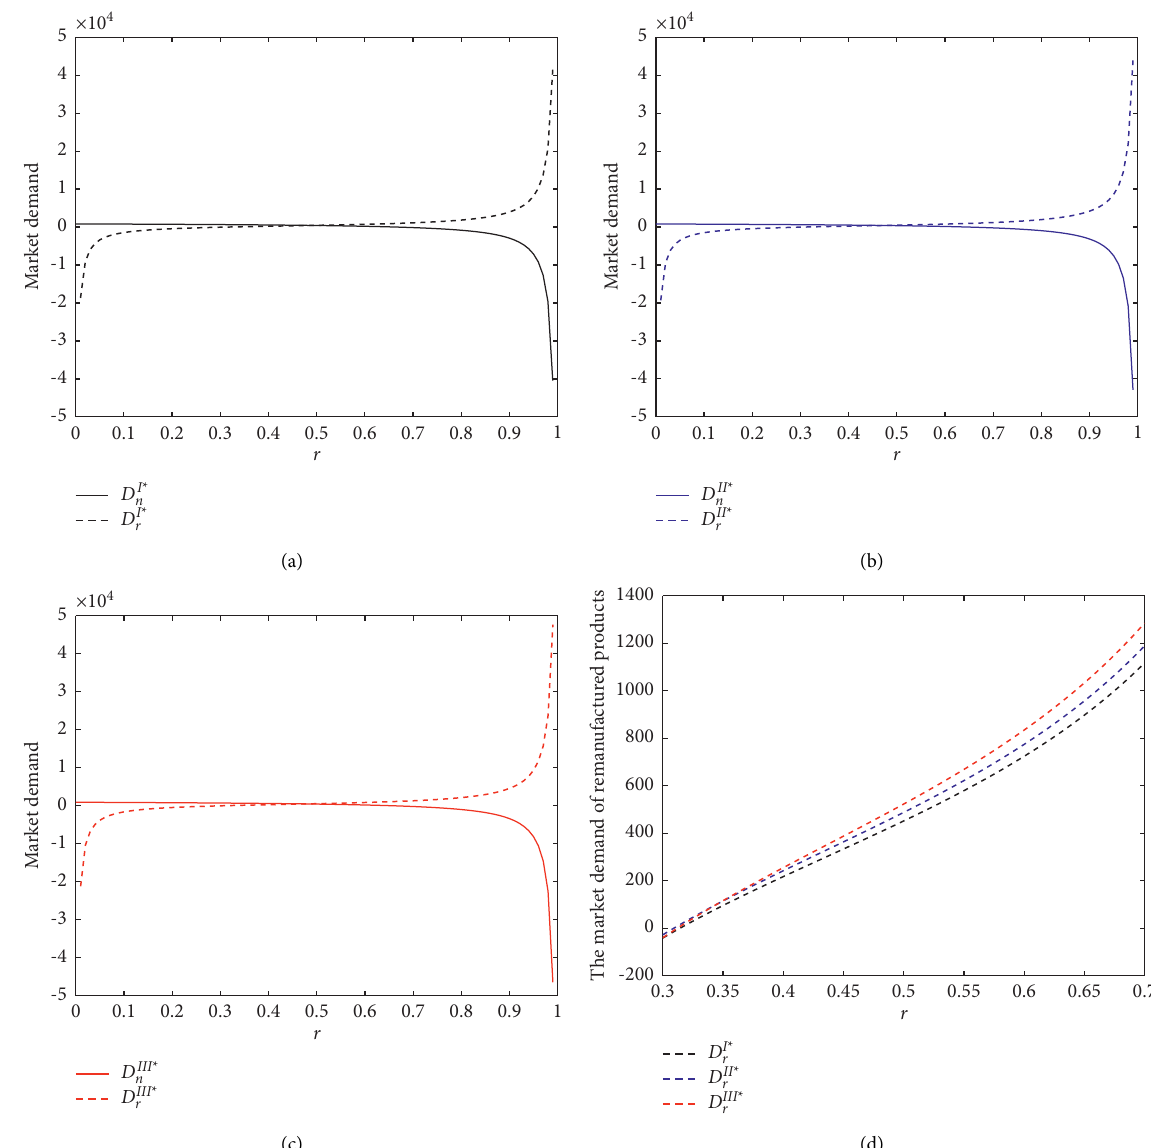
Figure 3: The effects of r on market demands. (a) Model I. (b) Model II. (c) Model III. (d) Remanufactured products